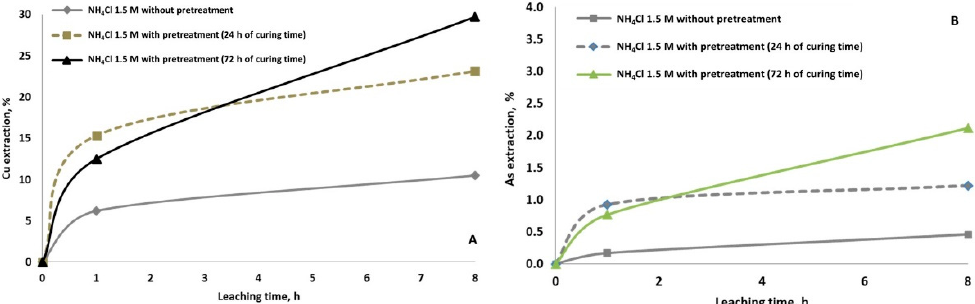
Figure 3. Copper ( A ) and arsenic ( B ) extraction at ambition condition using 1.5 M of NH 4 Cl without and with pretreatment (15 g/L of NaCl and curing time of 24 h and 72 h).